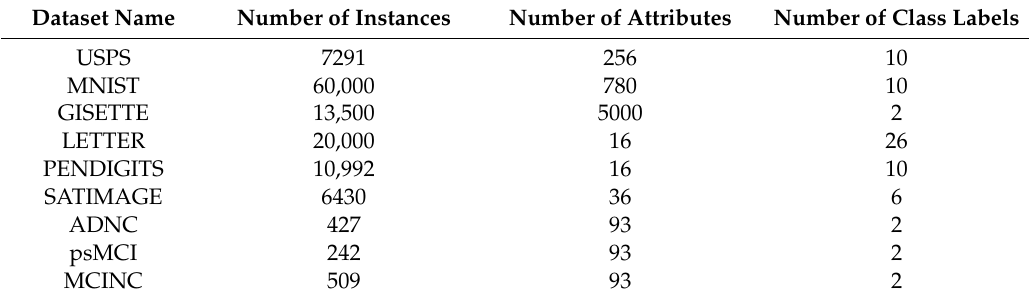
Table 1. The characteristics of the datasets.